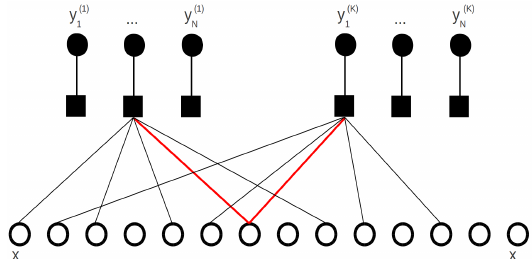
Figure 3: Sparse graph topology for the MASAR domain. The red lines indicate the edges of the scatterer (variable) which con- nects two observations from different aspects (denoted by the su- perscript). Note that this graph would correspond to a sparse sys- tem matrix A